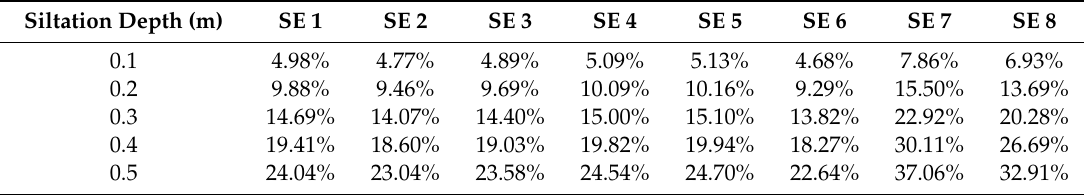
Table 10. Reduction ratio of flood control ability for di ff erent river segments (SE) under di ff erent siltation depths.